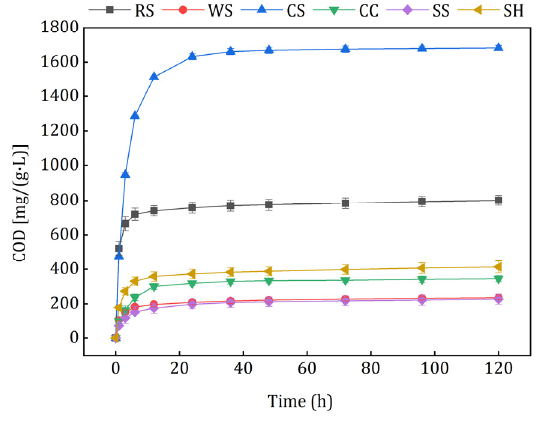
Figure 3. Carbon release curves of the investigated agricultural wastes.